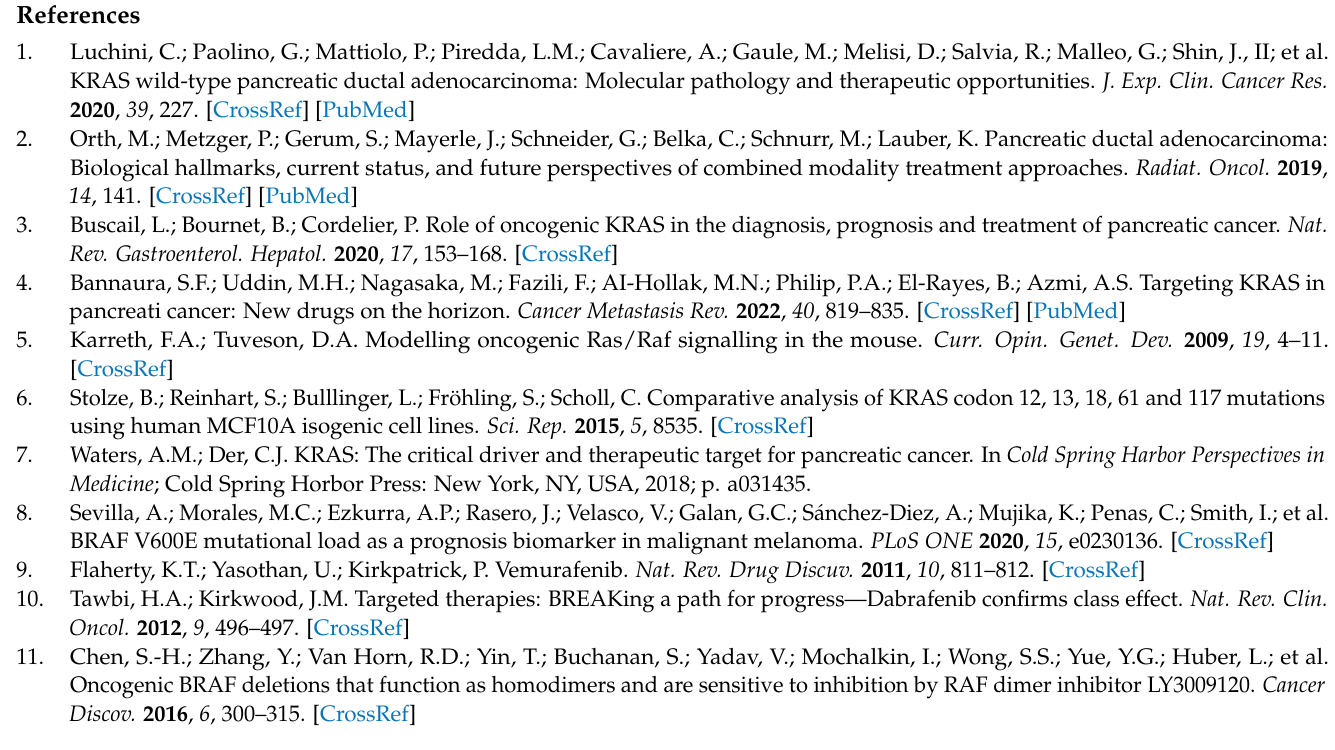
Blots, Table S2: Oligonucleotides sequences inserted into psiCHECK-1 for luciferase reporter assays, Table S3: Primer sequences used for